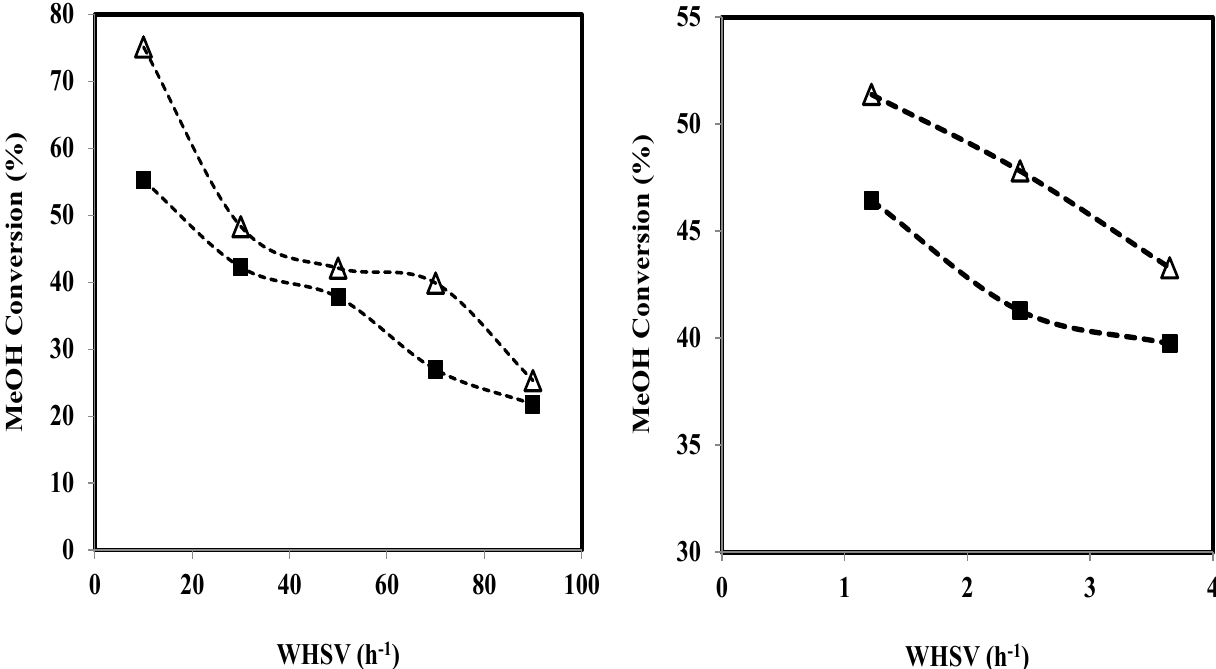
Fig. 6. Methanol conversion versus WHSV at 290 o C and 320 o C (∆) in the fixed bed reactor for catalyst particle size of P.S. <0.063mm. Dotted lines show the trend of changes